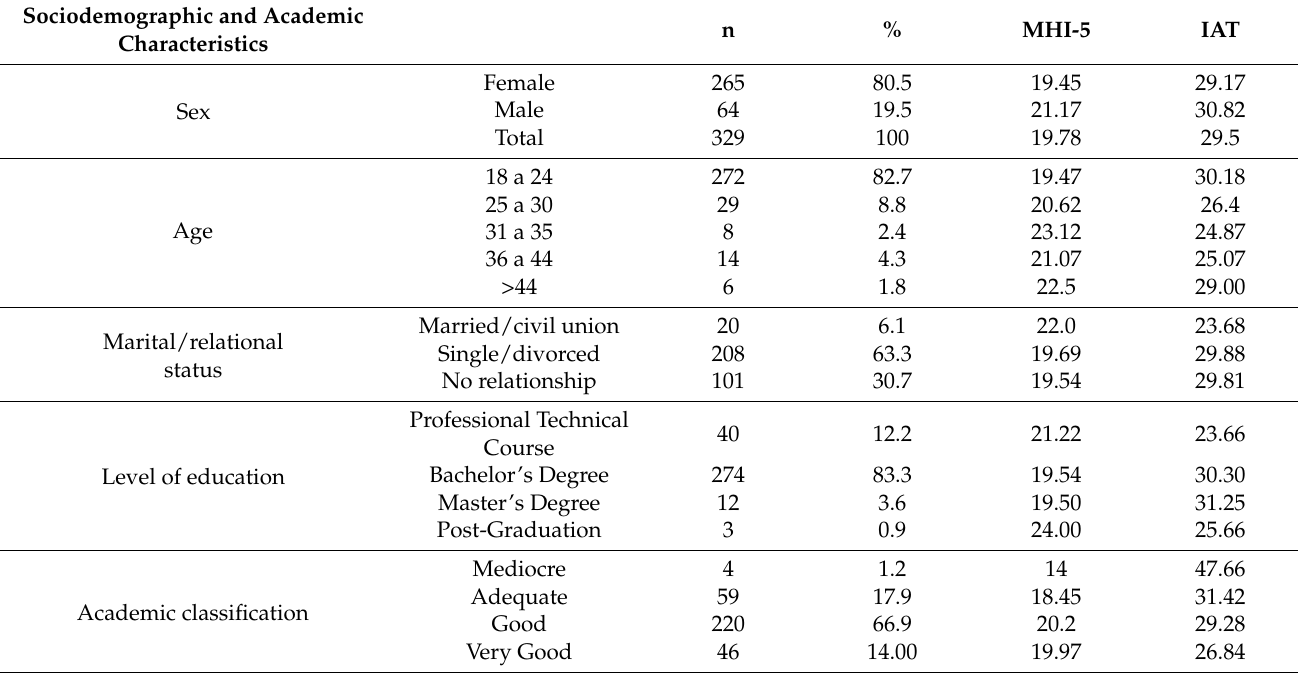
Table 1. Sociodemographic, academic characterization, Mental Health and Internet Addiction indexes of the